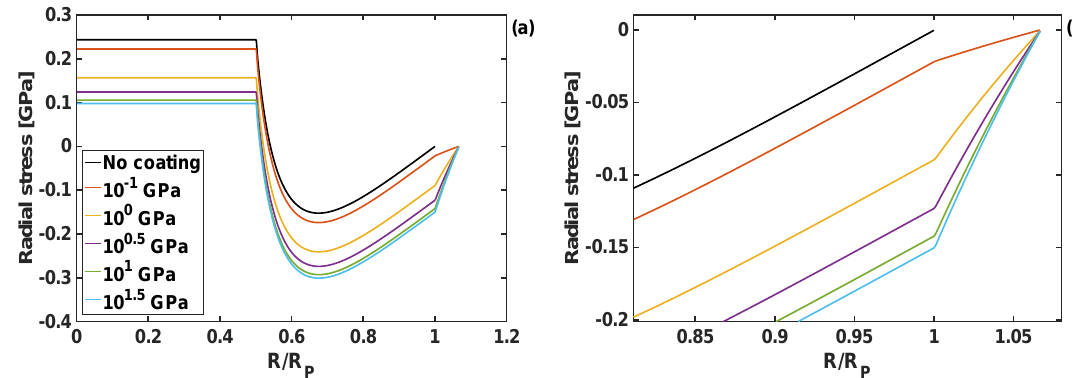
Figure 3: (a) Radial stress component as a function of normalised particle radius for different shear moduli of the coating, and h=10 nm and K T =1 GPa; (b) Zoom-in on the radial stresses close to the edge of the particle and within the coating.